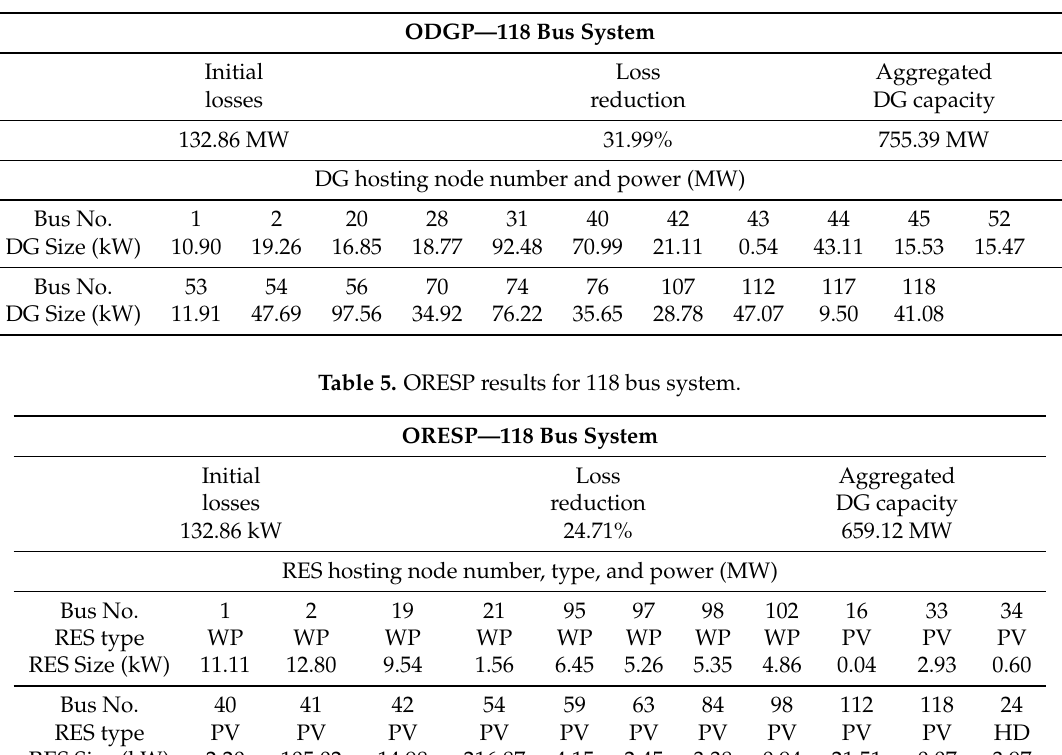
Table 4. ODGP results for 118 bus system.